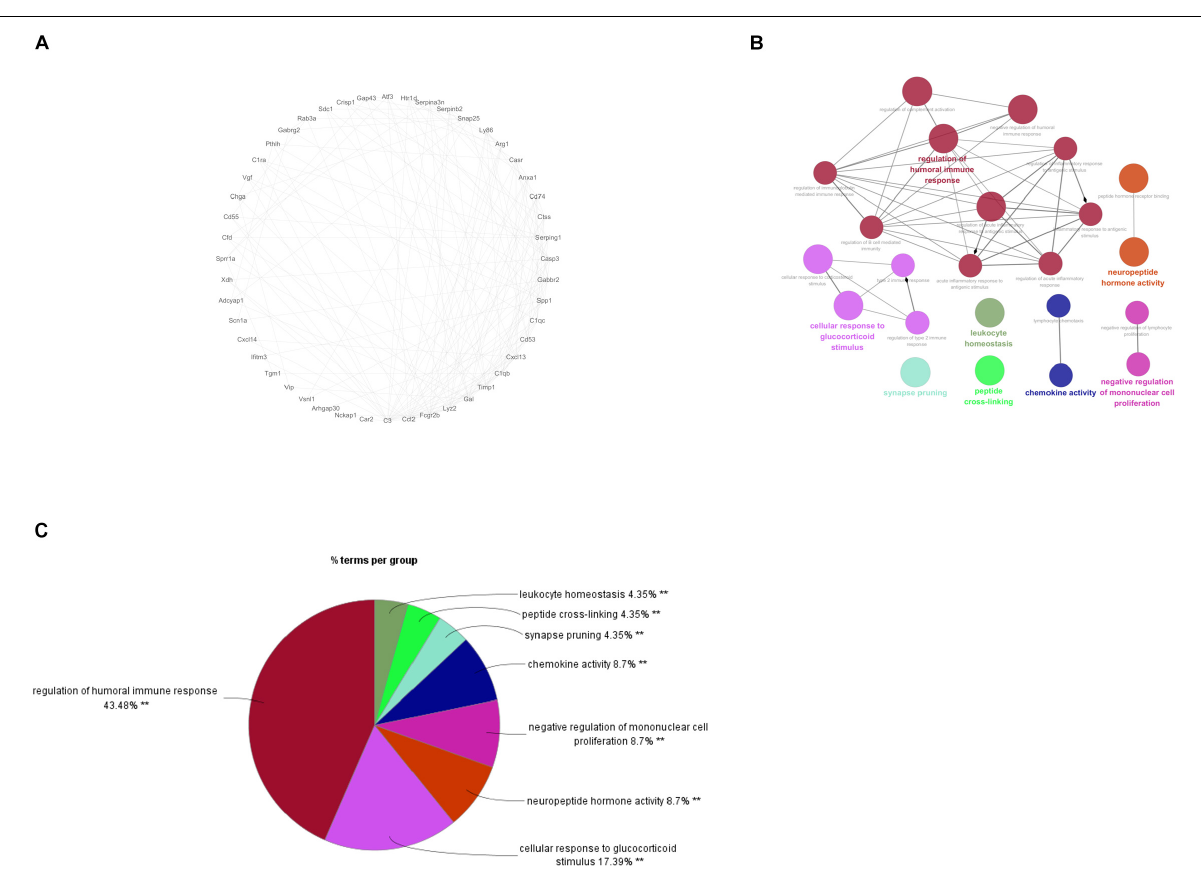
regulation of humoral immune response, cellular response to glucocorticoid stimulus, neuropeptide hormone activity, negative regulation of mononuclear cell proliferation and chemokine activity ( Figures 3B,C